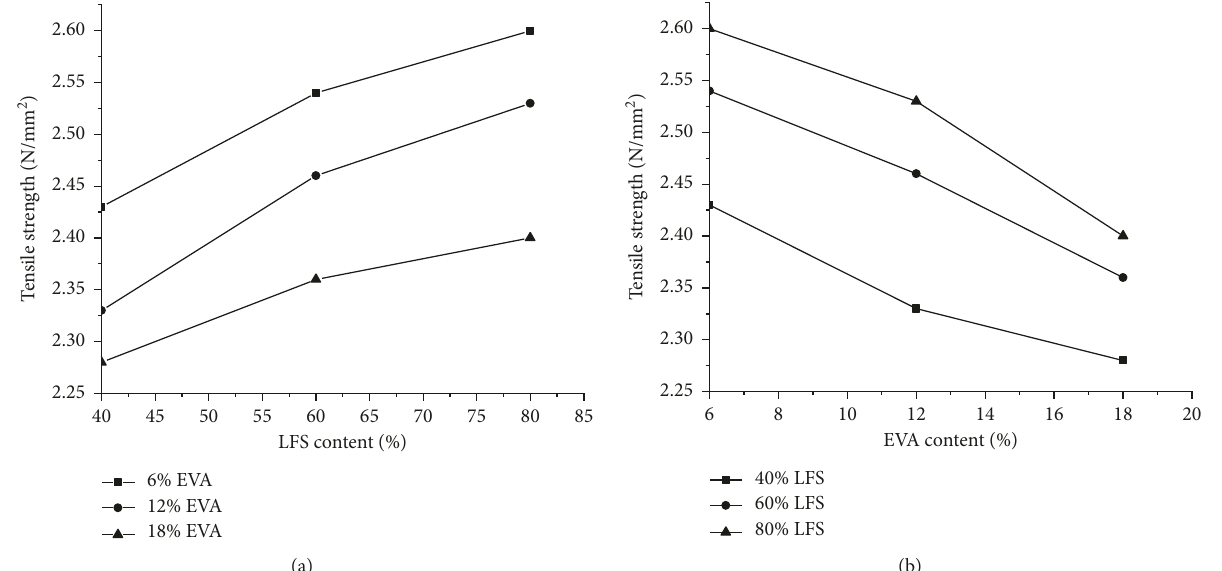
Figure 7: Comparative analysis of splitting tensile strength at a fixed rate of (a) EVA inclusion and (b) LFS inclusion.